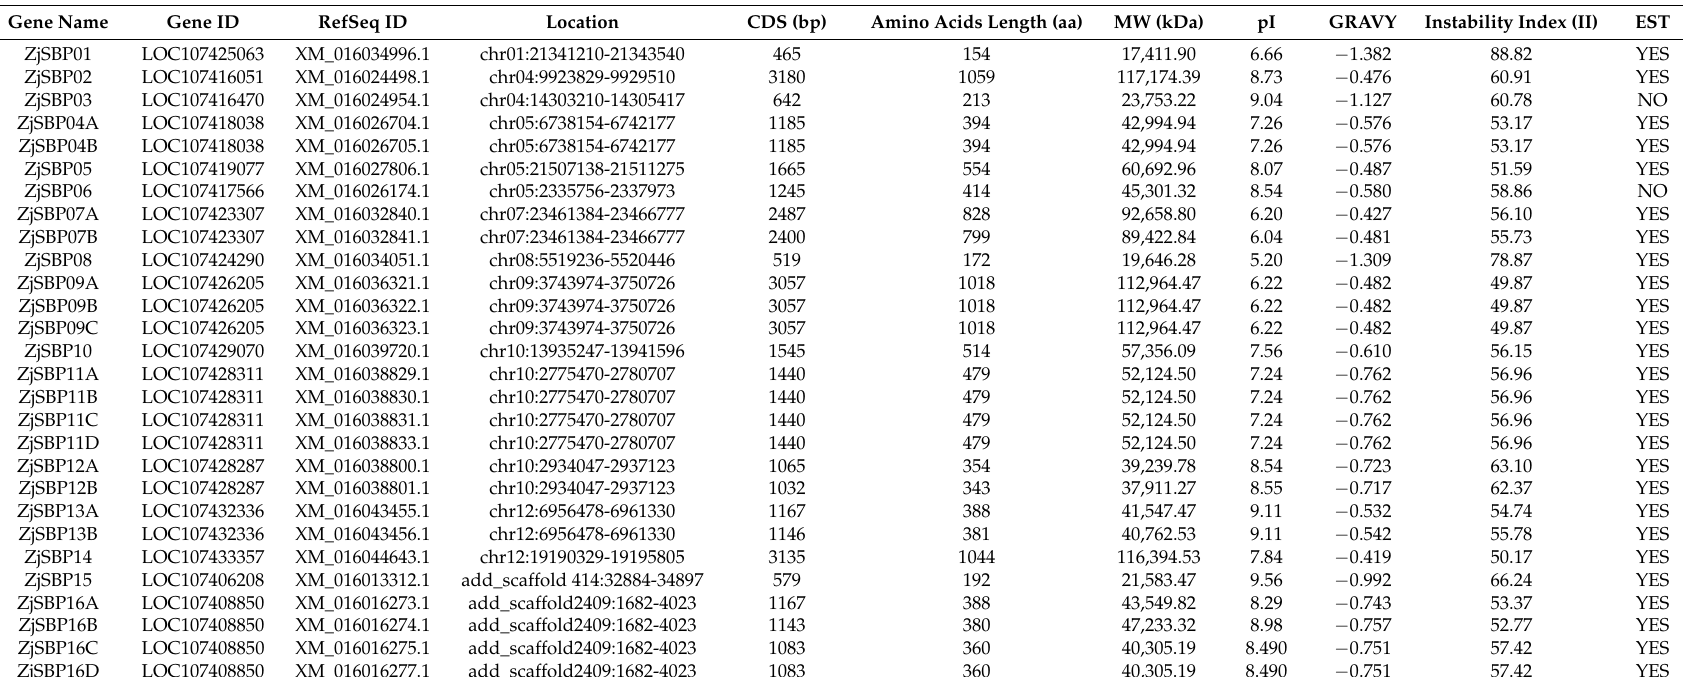
Table 1. The SBP-box gene family in Z. jujuba Mill.